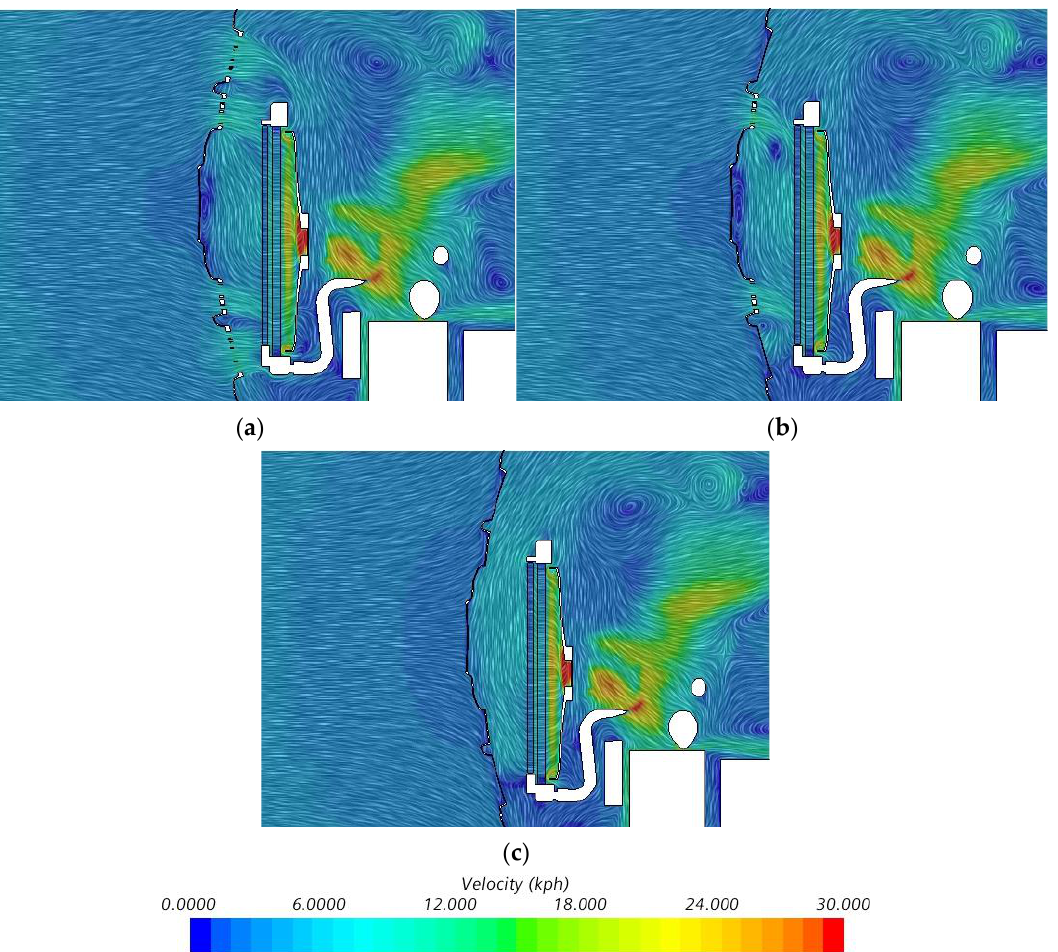
Figure 15. Comparisons of air side flow of the condenser under different upper grille schemes.